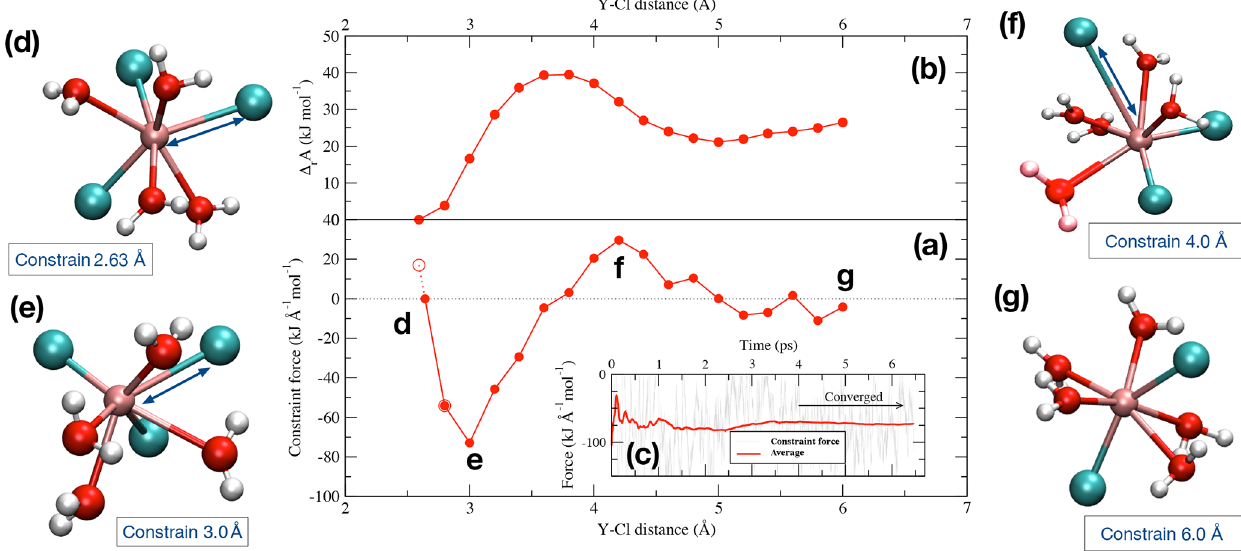
Figure 2. (a) Potential of mean force of the dissociation reaction of YCl 3 to YCl + 6.0Å. The evolution of the Helmholtz free energy is shown in panel (b) . In panel (c) , an example of the progress of the constraint force with simulation time at a Y–Cl distance of 3.0Å is shown (stage e ). Panels (d) – (g) indicate the different stages of the dissociation of the initial complex (see text for